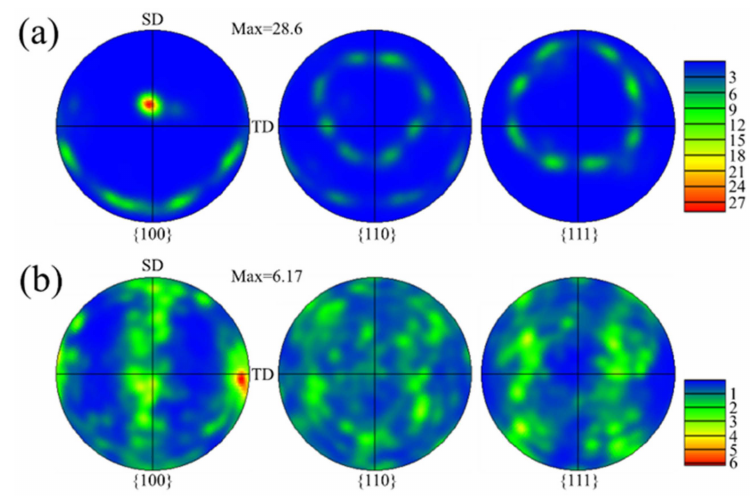
Figure 8. Pole figure with different pulse period: ( a ) 30 ms; ( b ) 100 ms.